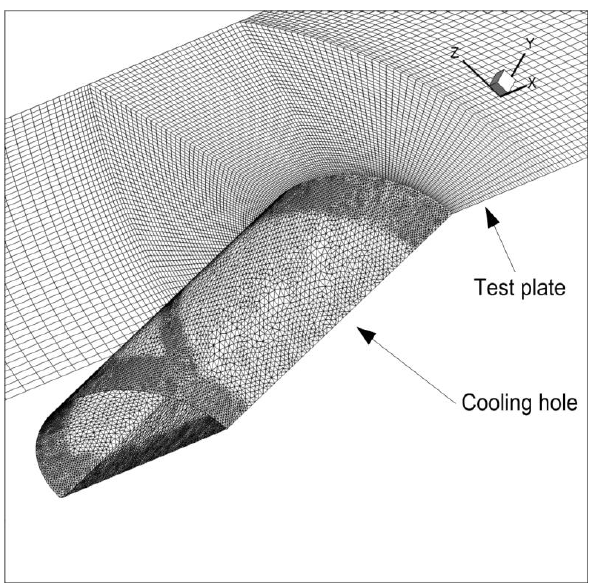
Figure 3. The near-field surface grid of the baseline case.